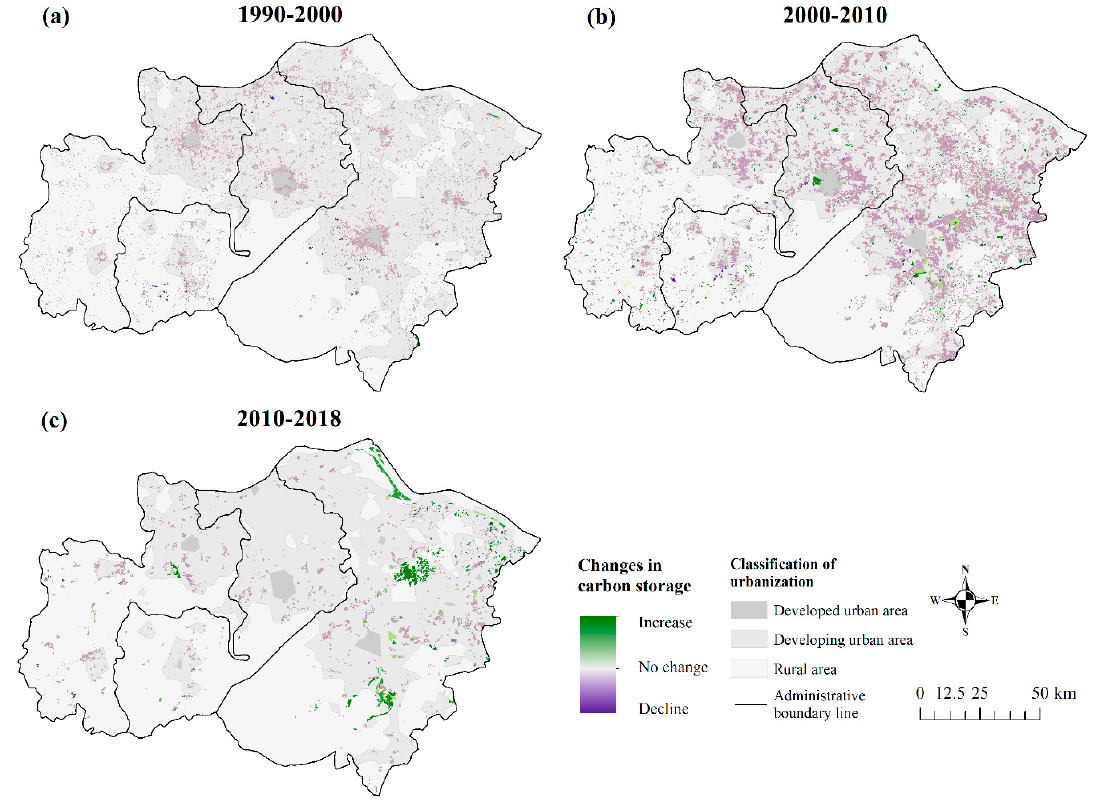
Figure 5. Spatial distribution of the changes in carbon storage from ( a ) 1990–2000, ( b ) 2000–2010, and ( c ) 2010–2018.